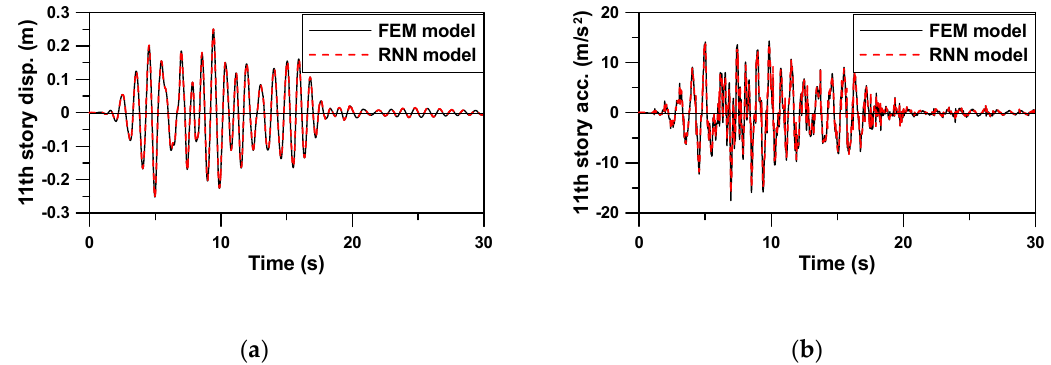
Figure 8. Comparison of the time history responses of Example 1 between FEM and RNN models (EQ No. 11): ( a ) Displacement time history; ( b ) Acceleration time history.